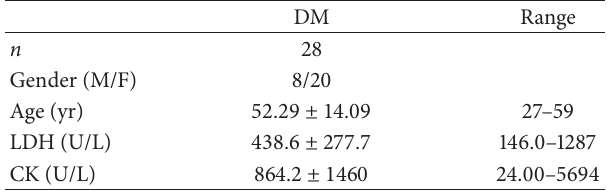
Table 1: Clinical features of DM patients included in the